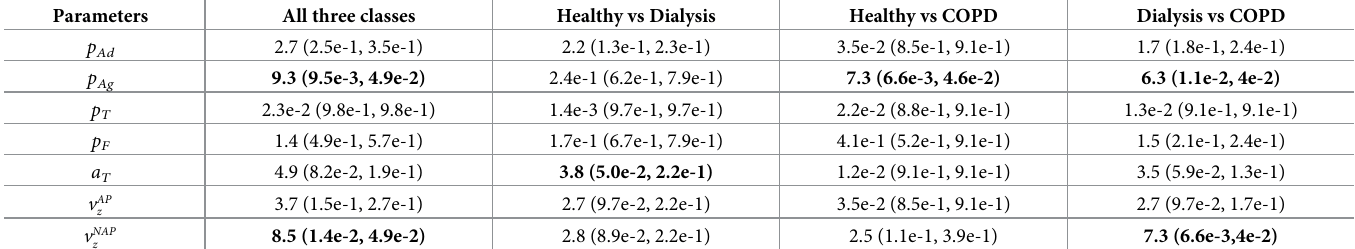
Table 1. Statistics (P-values, P-values corrected for multiple testing) of Kruskal-Wallis test using maximum a posteriori (MAP) estimates of the parameters. A higher value of the statistics and P-values smaller than 0.05 (bold) indicates that the medians of the estimated parameters of the corresponding groups are statistically differ- ent with a significance cutoff of 0.05. Healthy indicates healthy volunteers, Dialysis indicates patients under dialysis, and COPD stands for patients with COPD. The correc- tion of P-values for multiple testing has been done using the Benjamini-Hochberg procedure